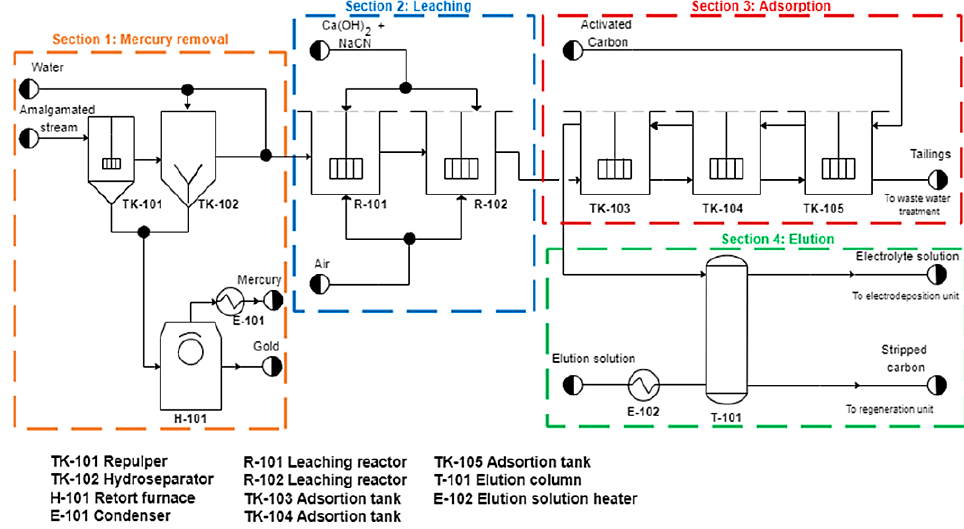
Figure 1. Process flow diagram for hydrometallurgical gold recovery using sodium cyanide as a leaching agent.